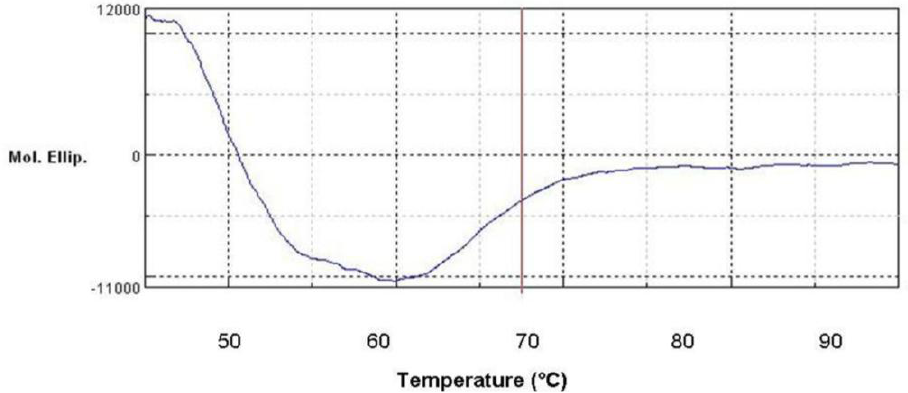
Figure 9. Molecular ellipticity value measurement for L2 mature lipase. Secondary structure prediction of L2 lipase was done by the CD spectra at 220